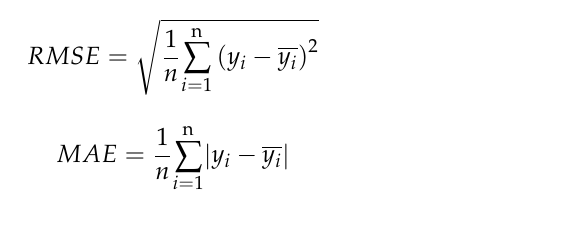
Table 4. Calculated RSME and MAE for position estimation of the dynamic Procapra przewalskii. Error Evaluation